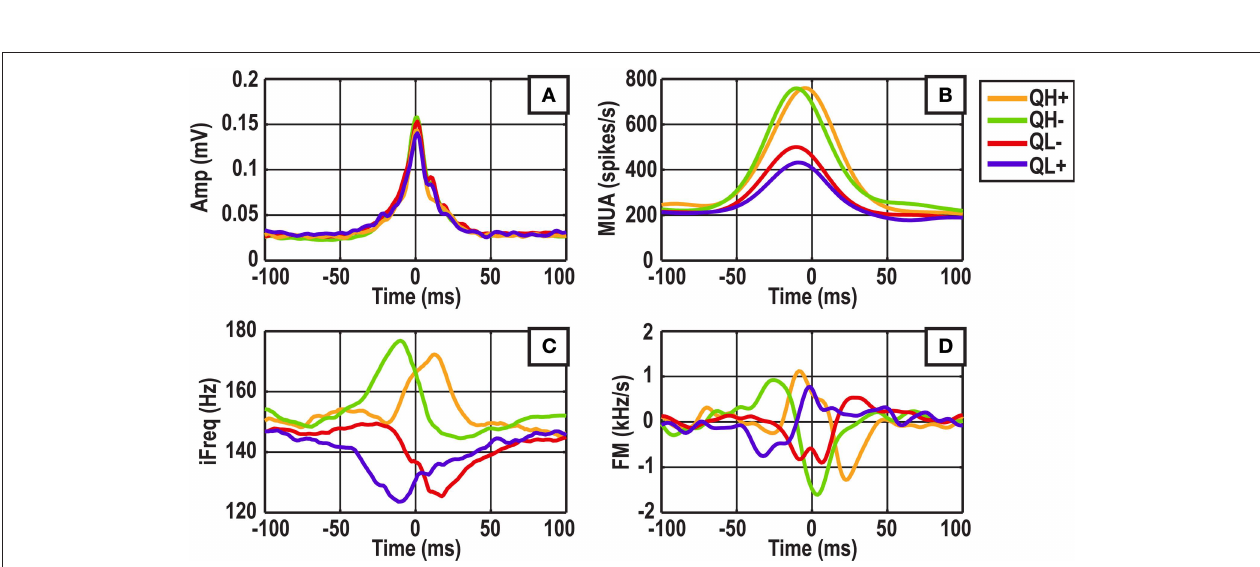
FIGURE 6 | Real data examples from each partition. Each segment is 100 ms long and is centered about the peak of the ripple. (A) The raw data, (B) the ripple signal, (C) the MUA, (D) the iFreq signal, and (E) the FM signal are displayed for